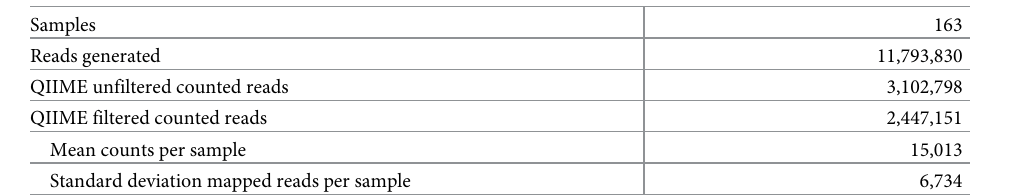
Table 1. Sequencing Results.